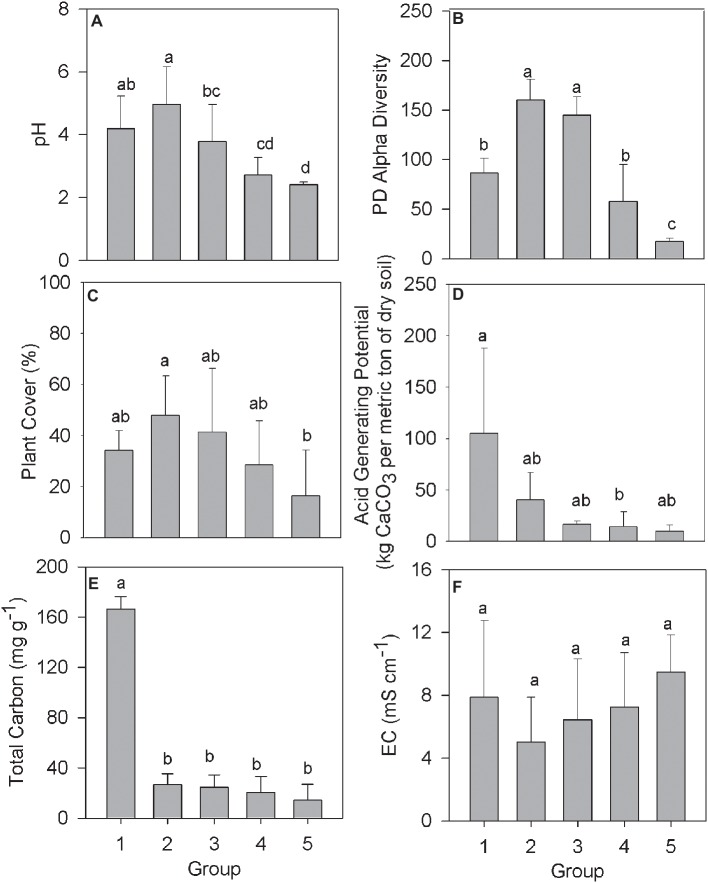
Biogeochemical data from the IKMHSS field study samples as a function of the five field study sample Groups (Figure 1, Supplementary Figure S2). (A) pH; (B) Alpha diversity; (C) % Plant cover; (D) Acid generating potential; (E) Total carbon; and (F) Electrical conductivity. Different letters indicate mean values that are significantly different (p < 0.01) across each group. Error bars indicate one standard deviation.